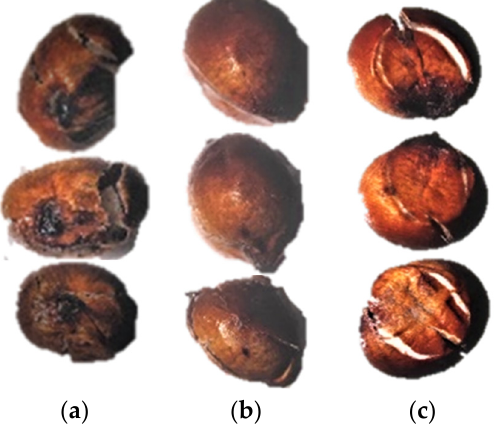
Figure 7. Sorghum seed compression rupture. ( a ) Compression along X -axis. ( b ) Compression along Y -axis. ( c ) Compression along Z -axis. After collecting the data of XYZ ’s three-axis damage force, a binary function with the independent variables of moisture content and X ( Y or Z ) axis dimensions is established, and the surface of the opposing force is obtained, as shown in Figure 8.